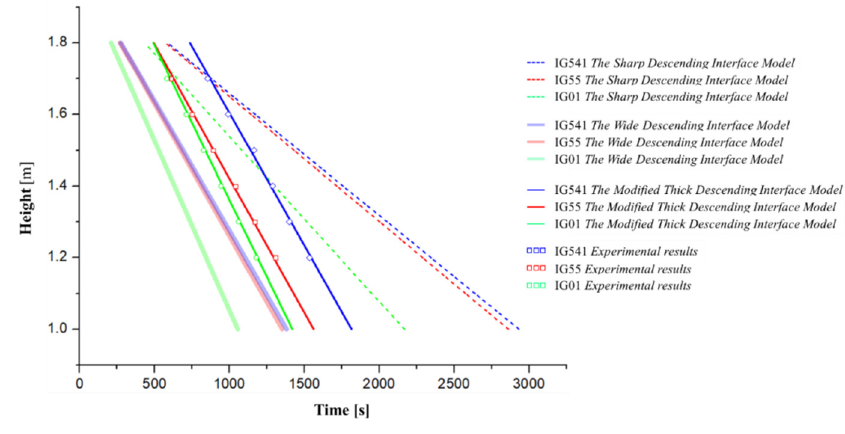
Figure 15. Comparison for the retention time according to the height of each model.